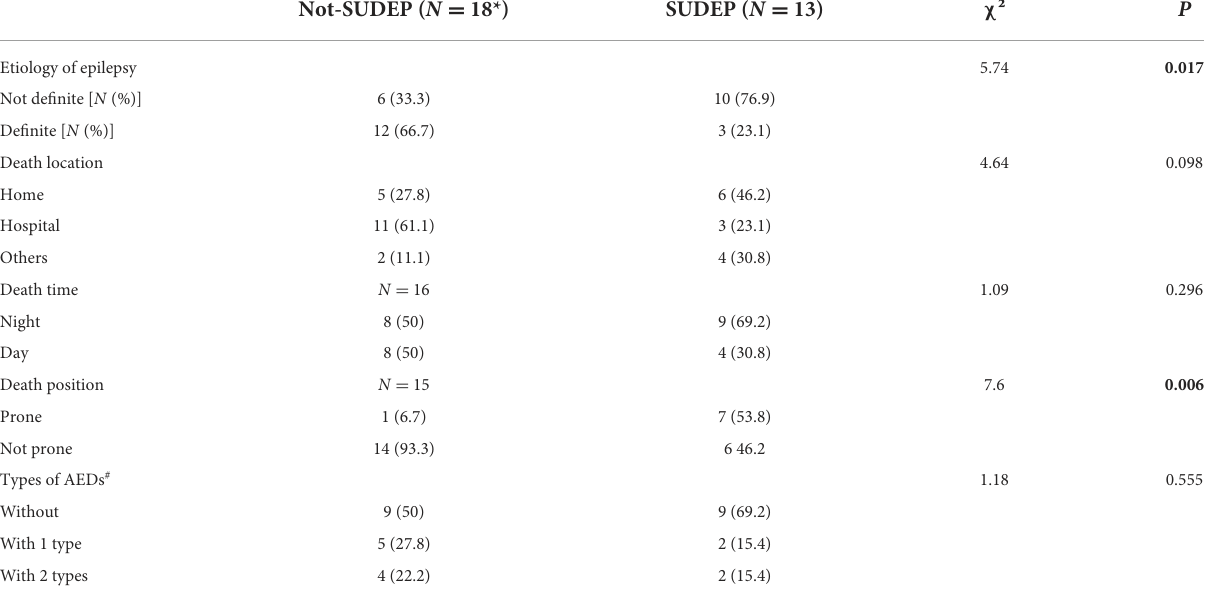
TABLE 1 Etiology, death circumstances, and AEDs of the SUDEP cases.